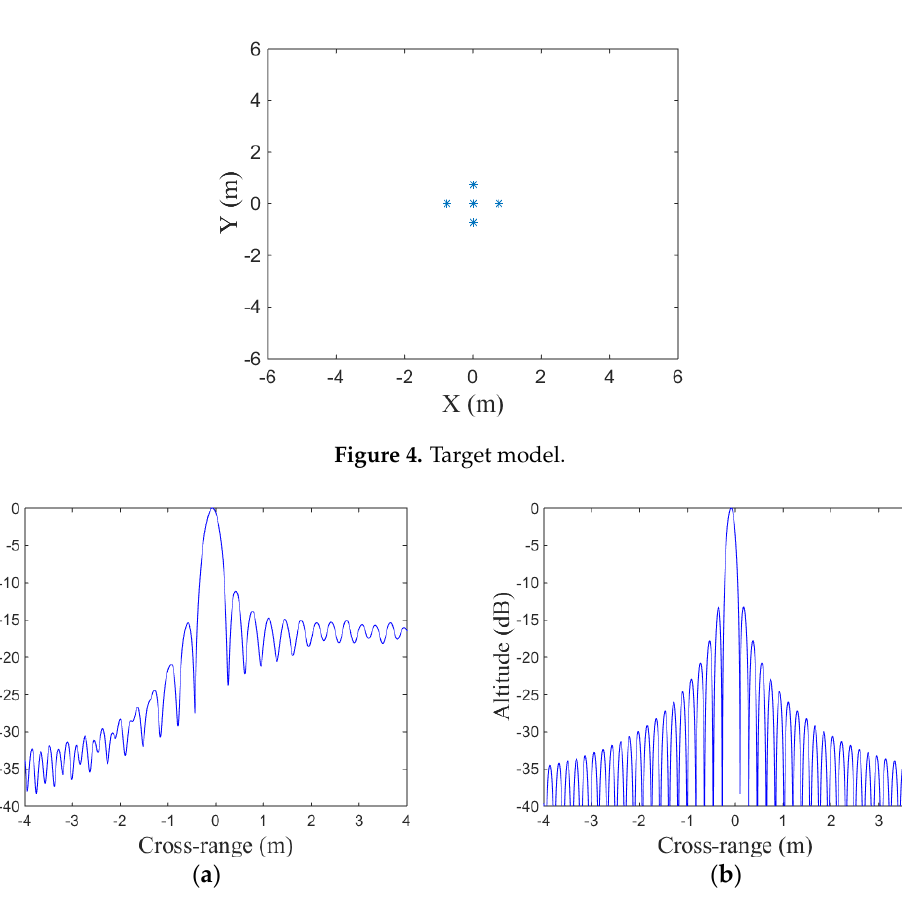
Figure 5. Cross-range point spread function (PSF): ( a ) cross-range PSF with LTFE; ( b ) cross-range PSF after calibrating LTFE.